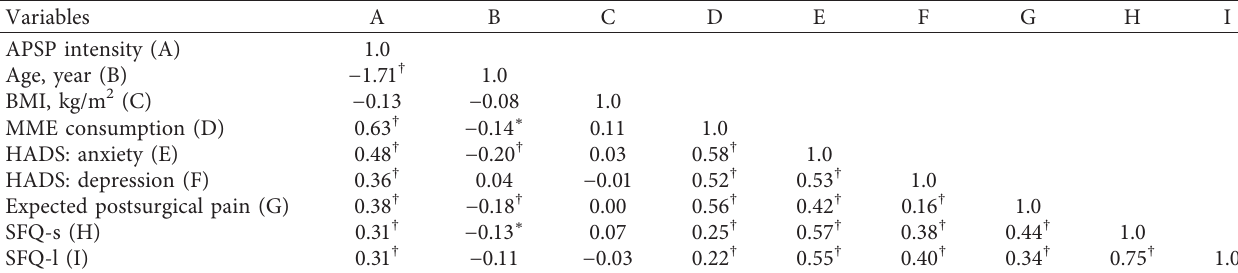
Table 3: Pearson’s correlation between age, BMI, MME consumption, psychological characteristics, and APSP intensity.